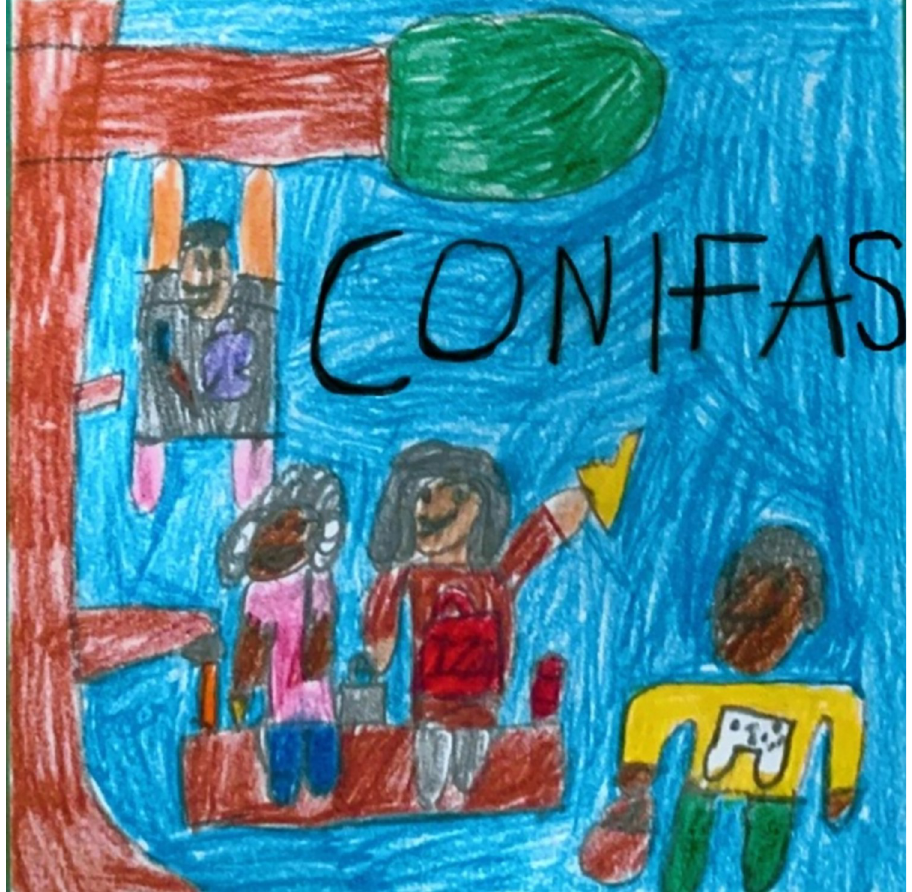
Fig 2. CONIFAS study logo based on the winning entry to the drawing competition.